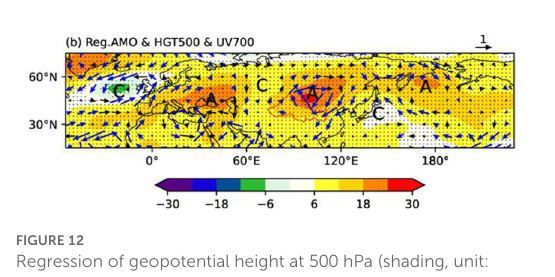
FIGURE12 Regression of geopotential height at 500 hPa (shading, unit: gpm) and winds at 700 hPa (vectors, unit: m/s) against the AMO index (a). A and C denote the centers of anomalous anticyclones and cyclones, respectively. Blue arrows and black dots denote significance at the 95% confidence level (Wu et al.,